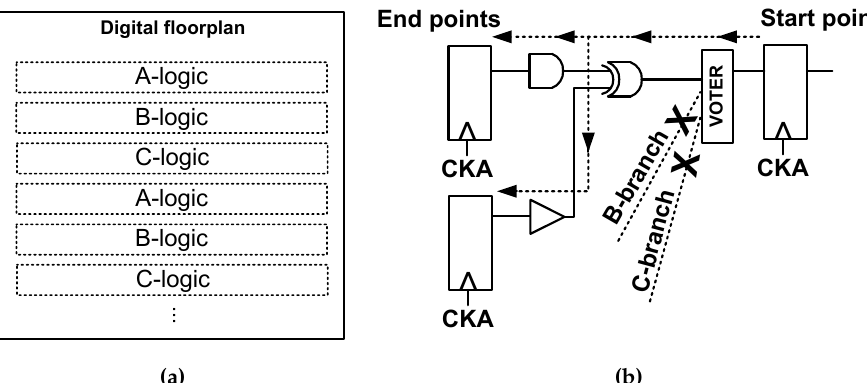
Figure 2. Logic placement of an interleaved design. ( a ) Interleaved physical floorplan; ( b ) Logic fan-in cone traceback.